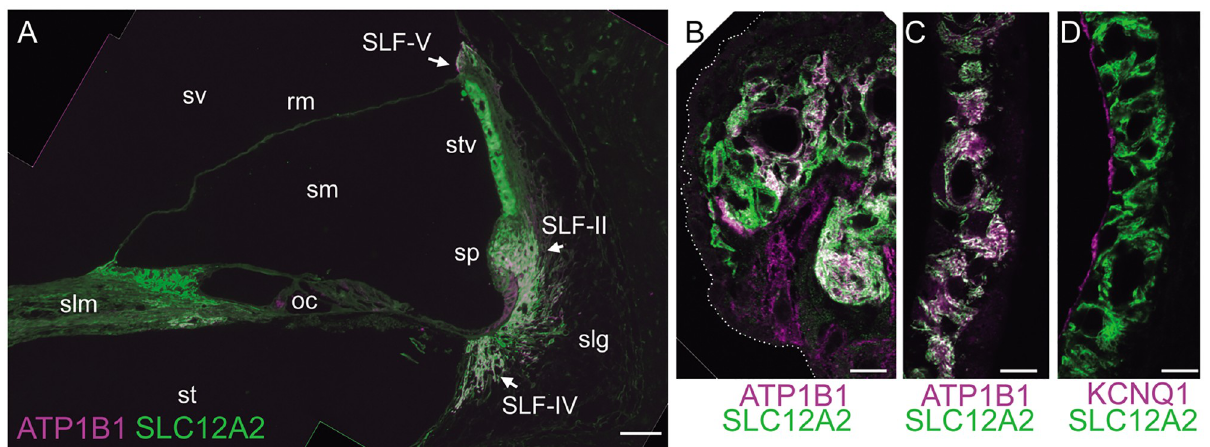
Fig 6. Distribution of SLC12A2 signals in the M . fascicularis cochlea. Paraffin sections of cochlear tissue from adult M . fascicularis (N = 3) were incubated with rabbit antiserum against SLC12A2 (green) and monoclonal antibody against ATPlBl (magenta) (A–C) or KCNQl (magenta) (D). (A) Overall image, showing the distribution of SLC12A2 in the cochlea. Scale bar, 50 μ m. (B–D) Magnified image of the spiral prominence (B) or stria vascularis (C,D) immunostained with the indicated antibodies. Dotted line in (B) indicates the apical surface of the epithelial cells of the spiral prominence. Scale bars, 10 μ m. oc, organ of Corti; rm, Reissner’s membrane; SLF-II, -IV, and -V, spiral ligament fibrocyte type II, IV, and V, respectively; slg, spiral ligament; slm, spiral limbus; sm, scala media; sp, spiral prominence; st, scala tympani; stv, stria vascularis; sv, scala vestibuli.